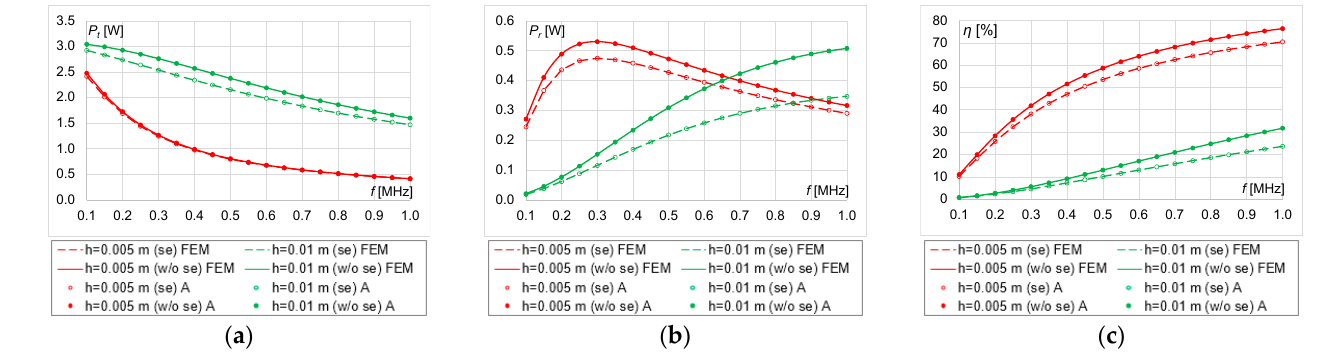
The graphs: transmitter, receiver power, and efficiency at the distances between the coils h = 0.005 m and h = 0.01 m for cases with and without skin effect are presented in Figures 8–11.